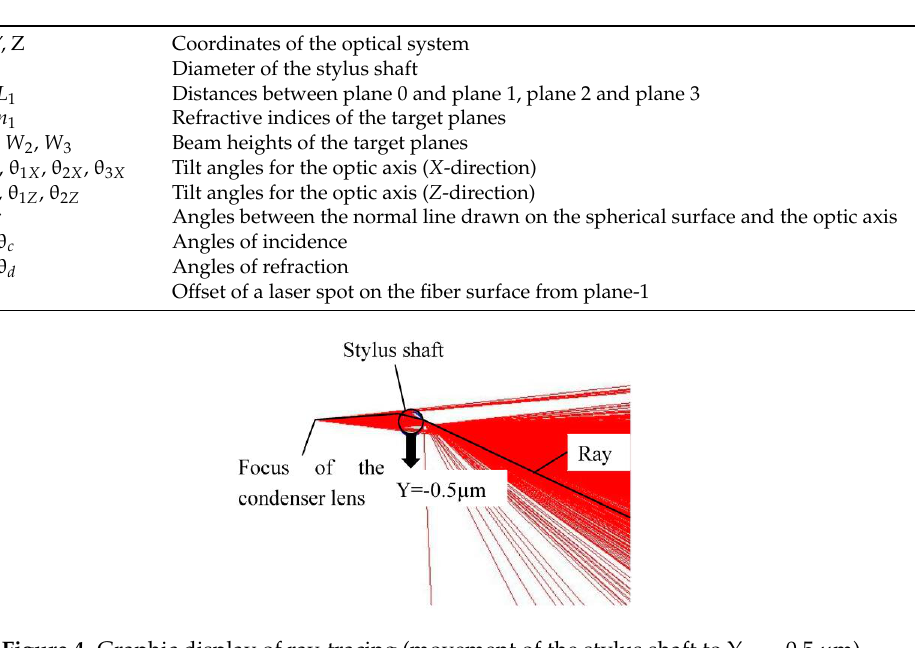
Figure 4. Graphic display of ray-tracing (movement of the stylus shaft to Y = −0.5 µm).